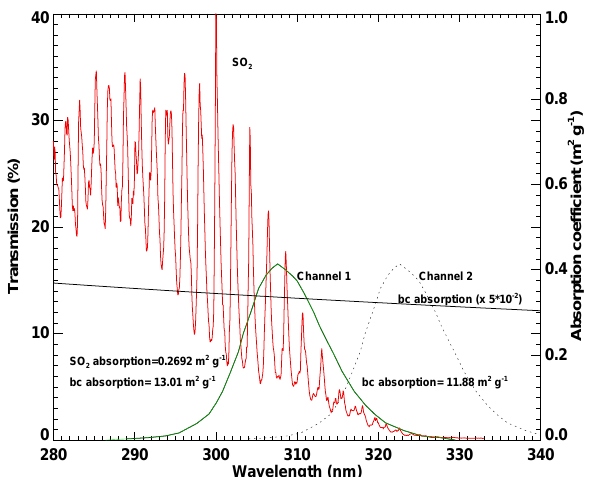
Fig. 17. Channel filter responses, black carbon (bc) absorption and laboratory measured SO 2 absorption. The channel-averaged values of the mass absorption coefficient for SO 2 and BC are provided on the